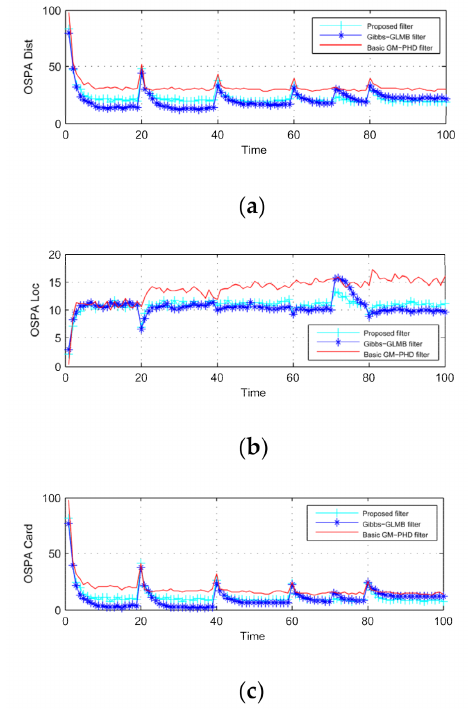
Figure 5. Comparison of different algorithms for 250 sample runs ( λ = 100, p D , k = 0.9). ( a ) Average Optimal subpattern assignment (OSPA) distances of different filters; ( b ) OSPA locations of different filters; ( c ) OSPA cardinalities of different